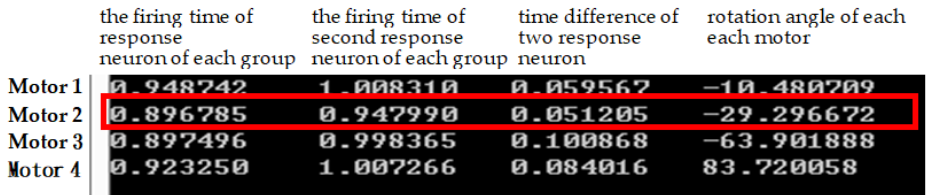
Figure 4. Interface between the ANM system and motors of the humanoid robotic arm.